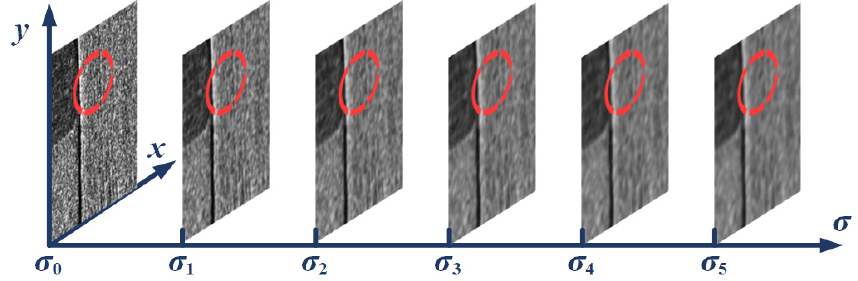
Figure 3. Gaussian scale space.